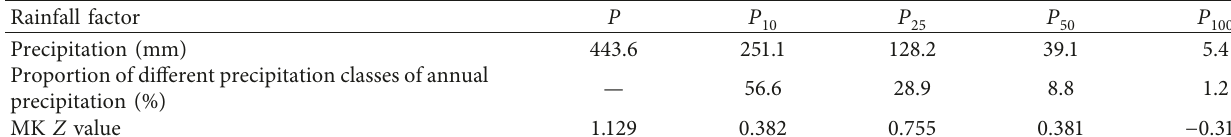
Table 1: Average precipitation in the HLR from 1966 to 2016.